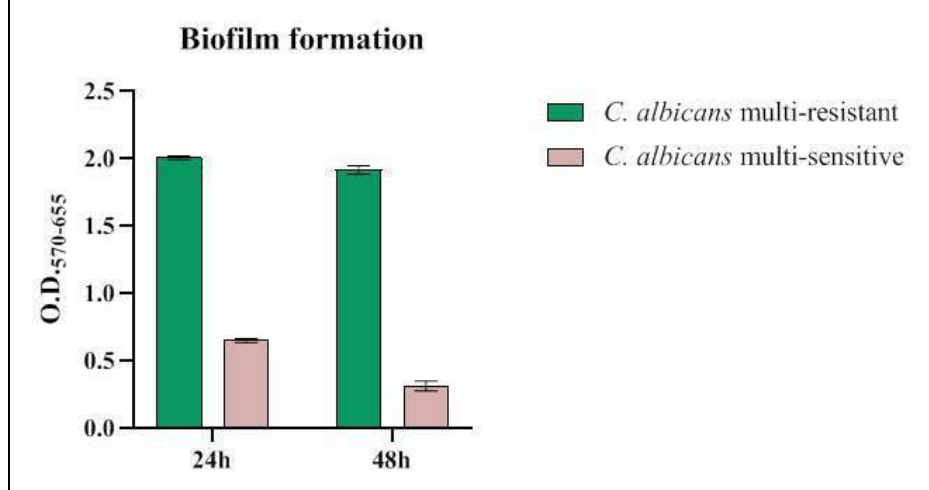
Figure 3. OD readings at 570–655 nm of biofilm growth of C. albicans from first and last swabs after 24 and 48 h.